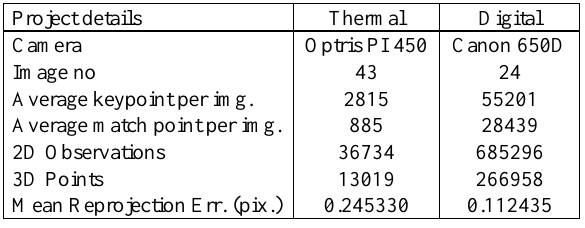
Table 1. Summary of photogrammetric projects